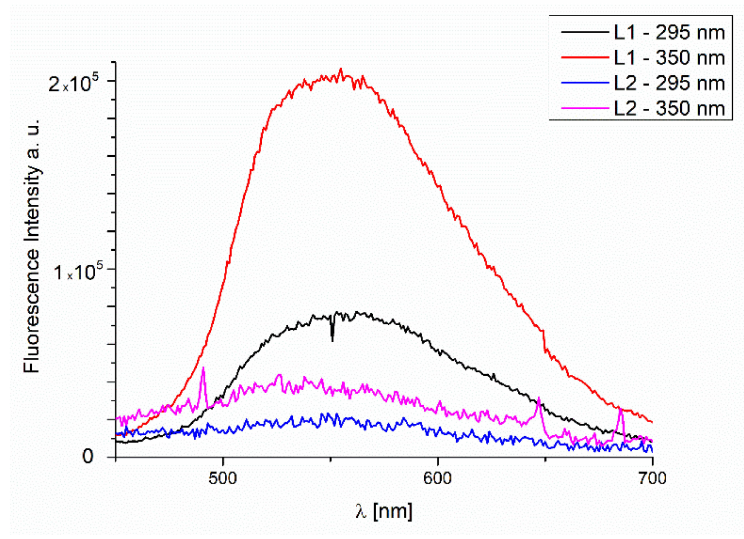
Figure 9. Solid state emission spectra of ligands L1 and L2 ; λ ex = 295 nm, λ ex = 350 nm.